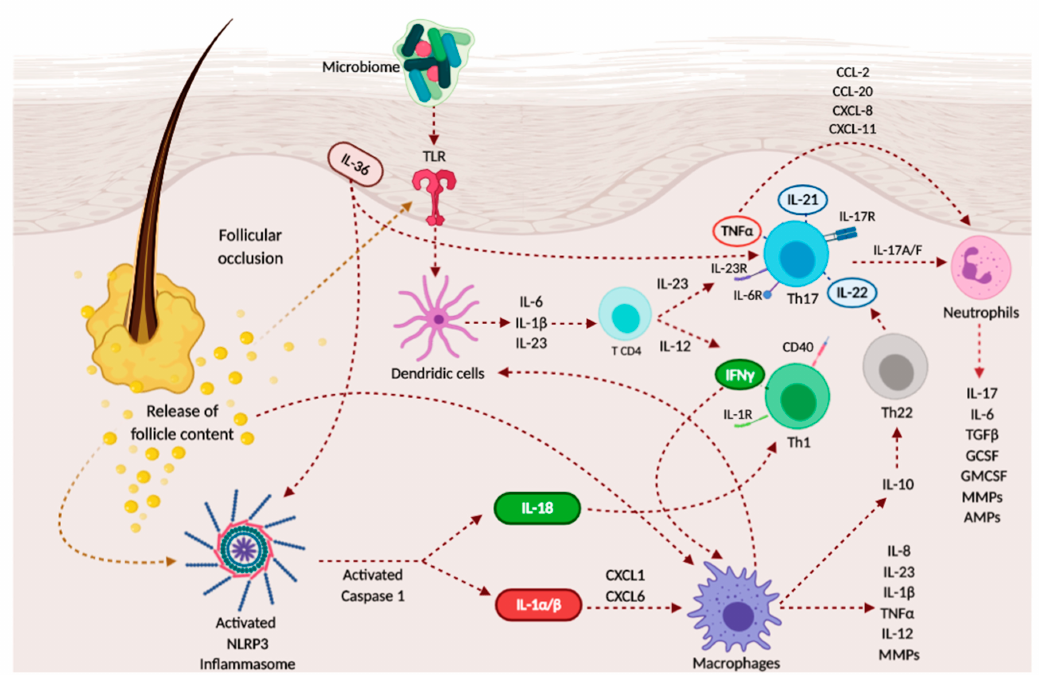
Figure 2. Schematic representation of the inflammatory pathways in hidradenitis suppurativa (HS), as for the pathways identified in this review.